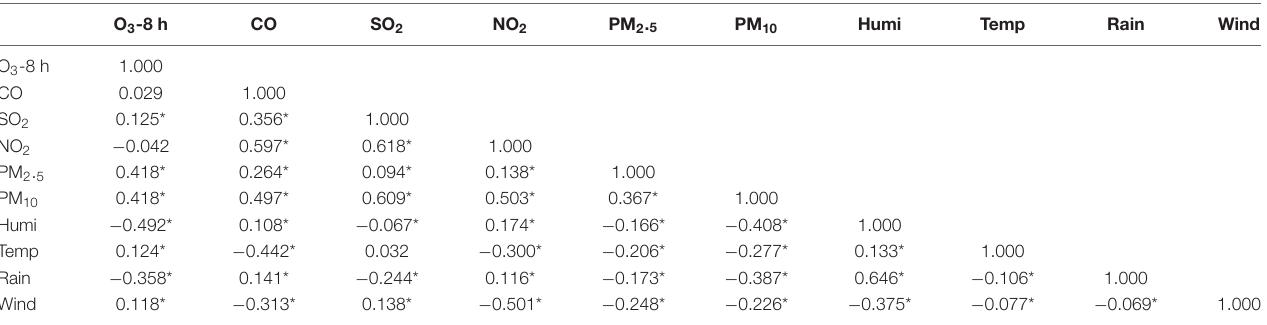
TABLE 4 | Correlation analysis between air pollutants and meteorological factors in Xiamen from 2016 to 2019. O 3 -8 h